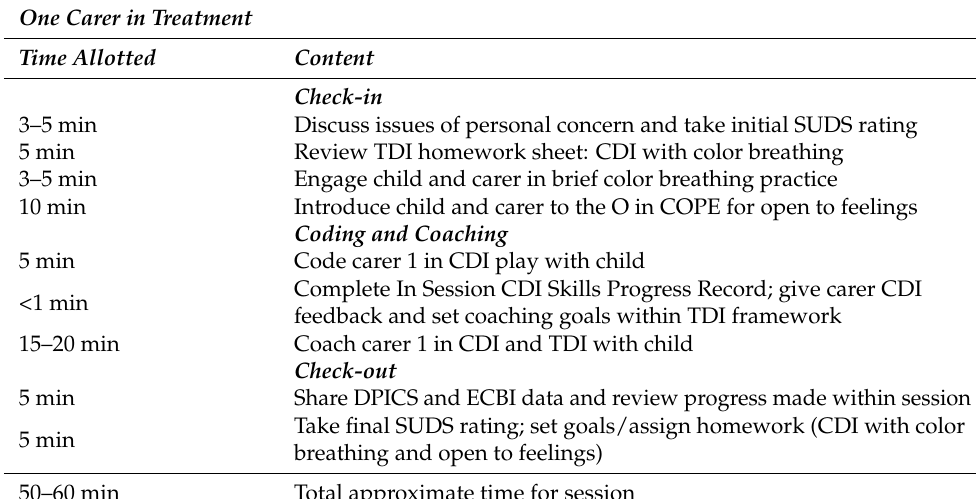
Table 4. Example TDI treatment session